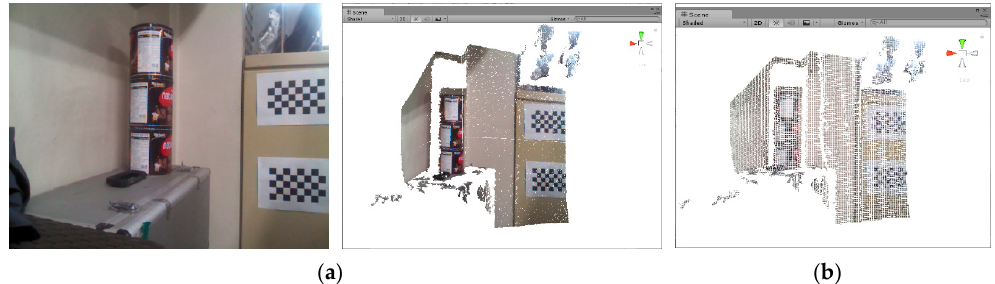
Figure 10. Point down sampling using a voxel grid: ( a ) Kinect rgb image and point cloud 248,935 p from depth image; ( b ) point cloud down sampling 55,328 p.